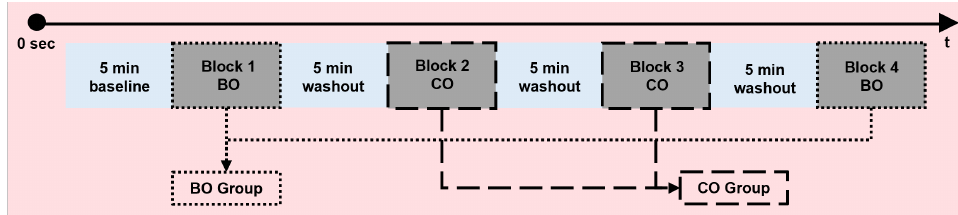
Figure 2. Division of signal into two distinct groups: CO and